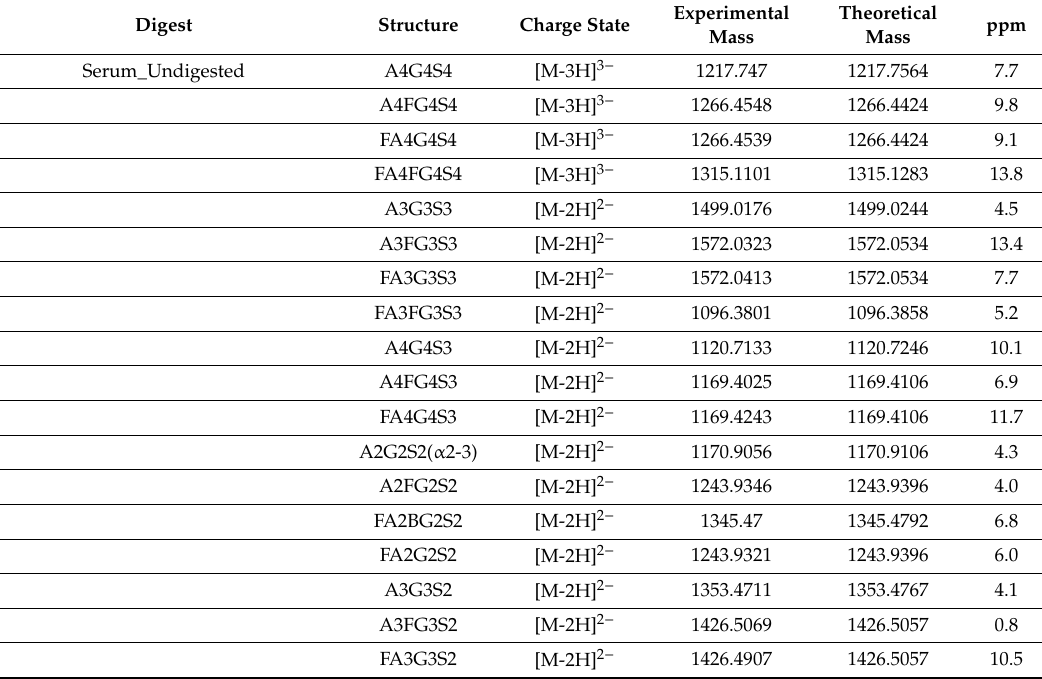
Table 1. Annotated glycan structures by CE-MS / MS and exoglycosidase